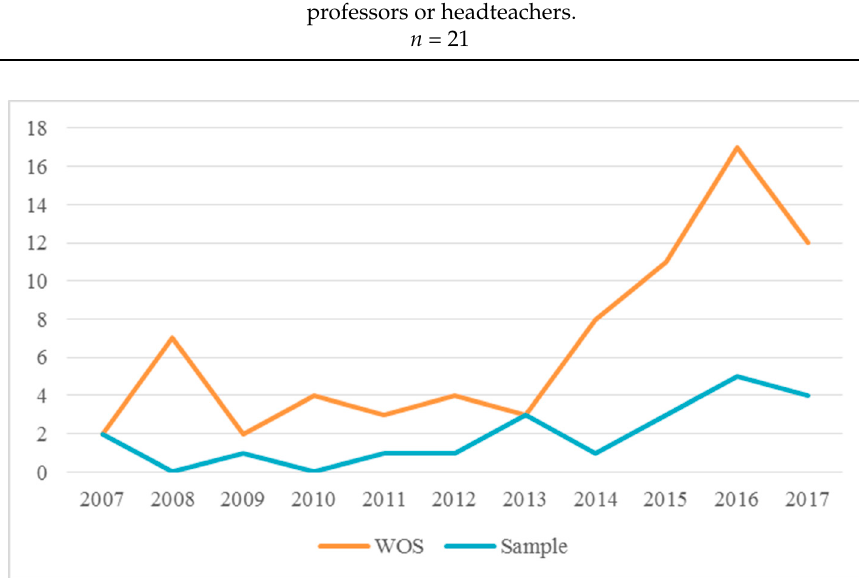
Table 1. Sample selection process.